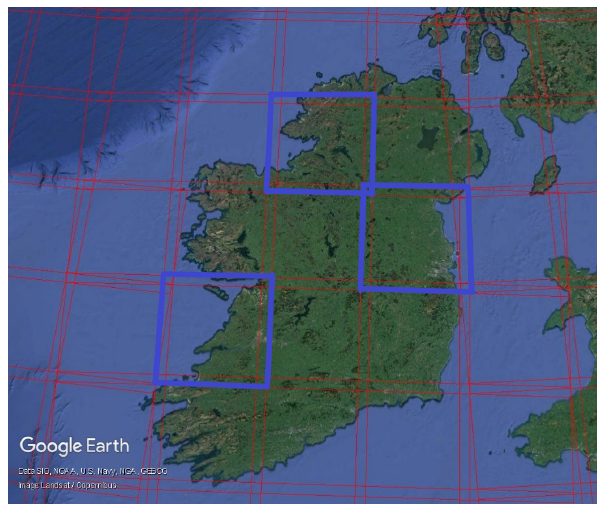
Figure 1. Satellite image of Ireland with various Sentinel-2 tiles outlined in red. The tiles highlighted in blue were used to train the ML algorithms (Source: https://www.google.com/earth/, last ac- cess: 30 April